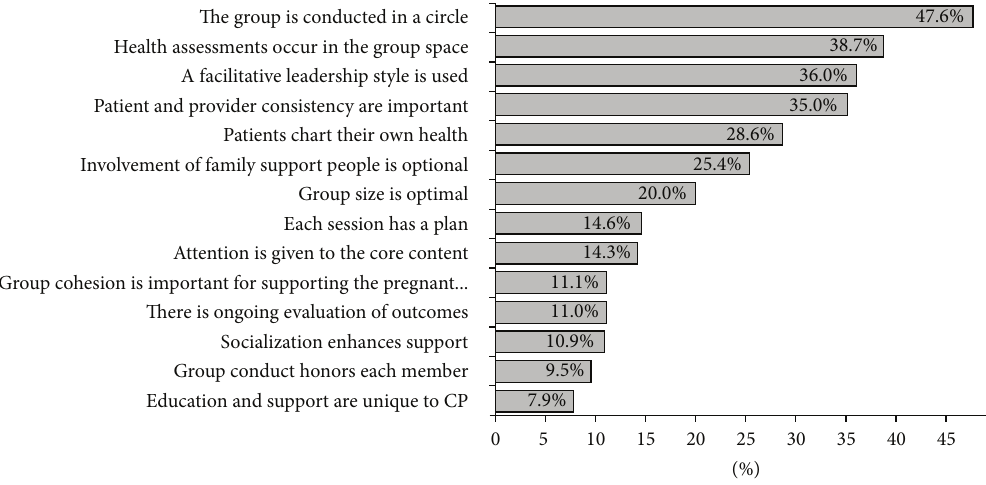
assessment occurs in the group space (38.7%; 𝑡 = −5.231, 𝑃 = 0.000 ), (3) a facilitative leadership style is used (36.0%; 𝑡 = −5.133 , 𝑃 = 0.000 ), (4) patient and provider consistency are important (35.0%; 𝑡 = −4.475 , 𝑃 = 0.000 ), and (5) patients chart their own health (28.6%; 𝑡 = −4.349 , 𝑃 = 0.000